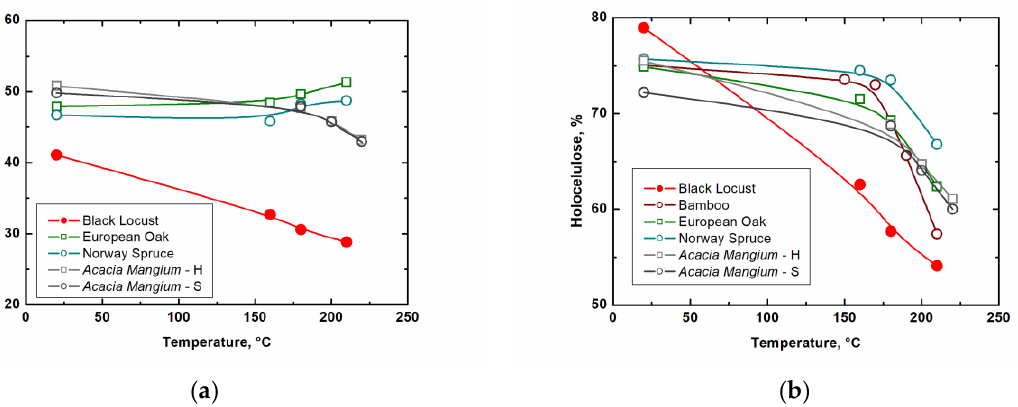
Figure 5. ( a ) Influence of thermal modification on cellulose; ( b ) influence of thermal modification on holocellulose (bamboo [19], European oak, Norway spruce [20], Acacia mangium —heartwood, sapwood